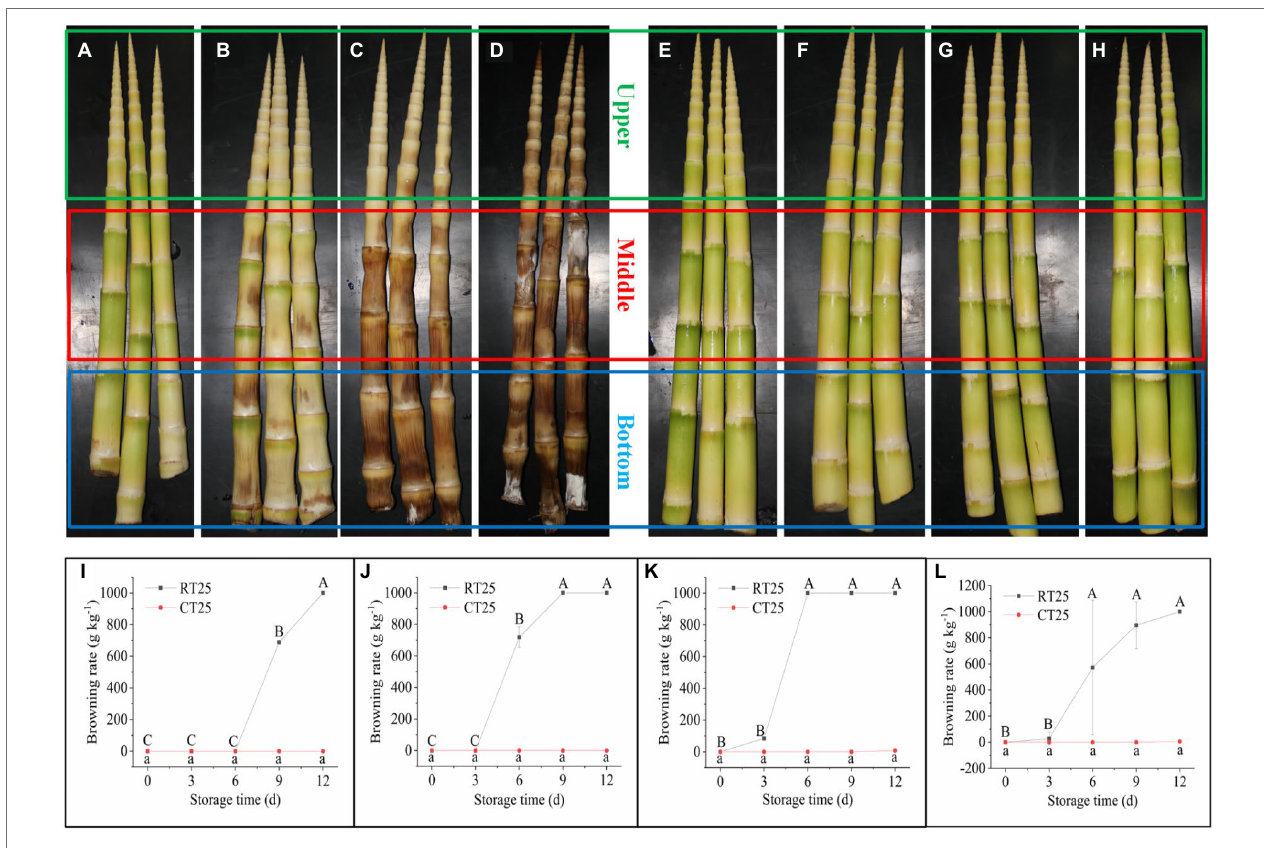
FIGURE 4 | Shoot browning during storage at 25 ° C and 4 ° C. RT25, bamboo shoots stored at room temperature and analyzed at 25 ° C; CT25, bamboo shoots stored at cold temperatures and analyzed at 25 ° C. (A–D) The postharvest bamboo shoots browned rapidly at 25 ° C for shoots stored for 3 (A) , 6 (B) , 9 (C) , and 12